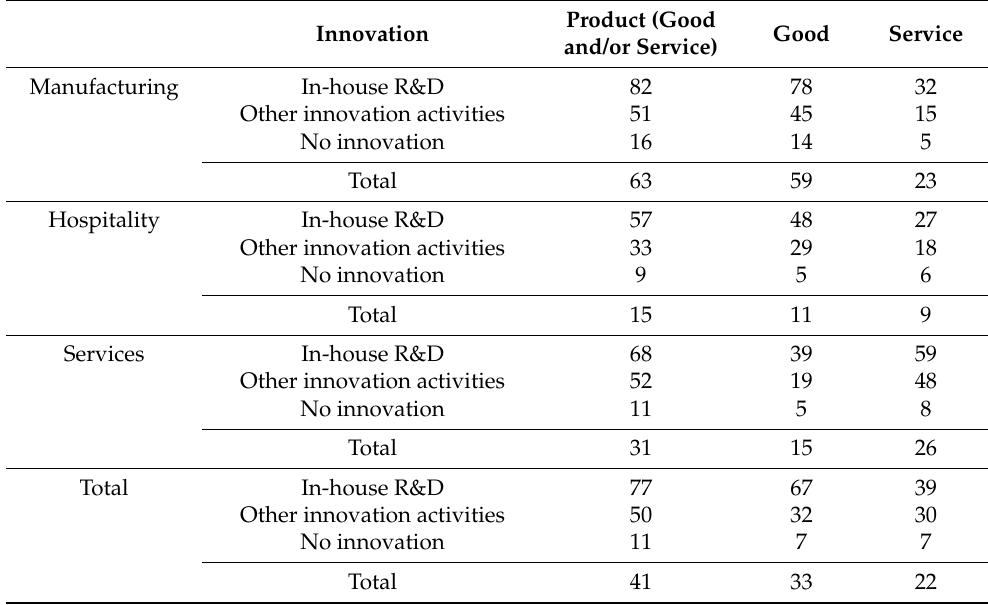
Table 11. Product innovators by industry